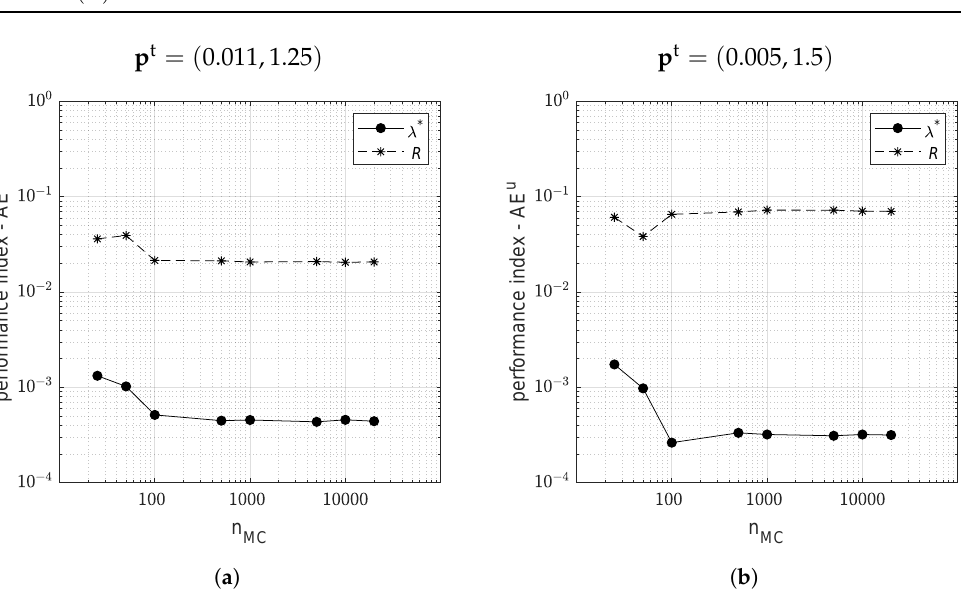
Figure 7. Convergence of gPCE-ES with increasing ensemble size for ( a ) p t = ( 0.011,1.25 ) and ( b ) p t = ( 0.005,1.5 )